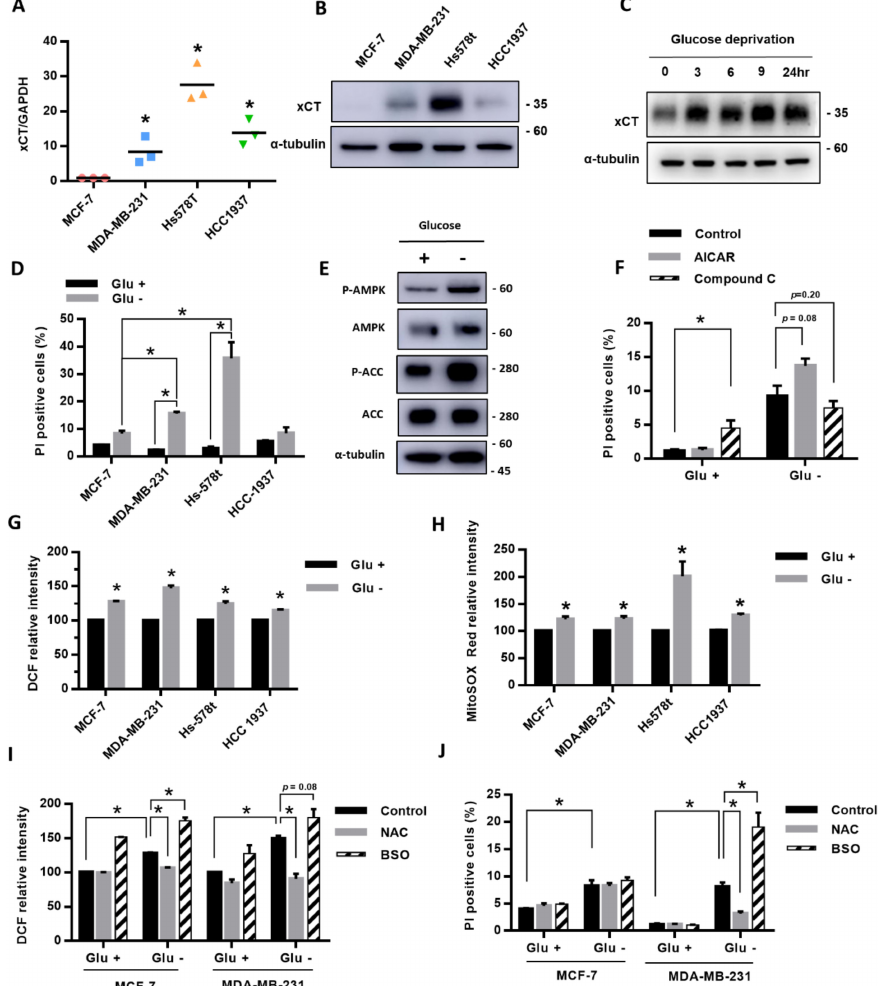
Figure 1. The breast cancer cells with high expression of xCT had higher ROS levels and a higher cell death rate under glucose deprivation. ( A , B ) The expression of xCT in breast cancer cell lines (MCF-7, MDA-MB-231, Hs-578t, and HCC-1937) in the normal culture medium was detected by real-time RT-PCR ( A ) and Western blot ( B ). The relative expression level of xCT of MCF-7 was set as 1. ( C ) The protein levels of xCT after glucose deprivation for 3, 6, 9, and 24 h in MDA-MB-231 cells were detected using a Western blot. ( D )The four breast cancer cell lines were cultured in the medium with or without glucose (25 mM) for 24 h. The cell death rate was evaluated by the flow cytometry with PI exclusion assay. ( E , F ) MDA-MB-231 cells were treated with or without glucose deprivation for 24 h. The protein levels of the AMPK pathway were detected using a Western blot ( E ). The cells were cotreated with the AMPK activator 5-aminoimidazole-4-carboxamide ribonucleotide (AICAR, 1 mM) or the AMPK inhibitor Compound C (Com C, 10 µ M). The cell death rate was detected using flow cytometry with a PI exclusion assay ( F ). ( G , H ) The levels of intracellular ROS and mtROS were detected using flow cytometry with DCFH-dA staining ( G ) and mitoSOX Red dye ( H ). The measured value of ROS from the cells cultured in the glucose-containing medium (control) was normalized as 100%. ( I ) The MCF-7 and MDA-MB-231 cells were cultured in the medium with or without glucose and cotreated with the antioxidant N-acetyl-cysteine (NAC, 1 mM) or the glutathione biosynthesis inhibitor L-buthionine-S, R-sulfoximine (BSO, 150 µ M). The levels of intracellular ROS after NAC or BSO treatment were detected using flow cytometry with DCFH-dA staining. ( J ) The cell death rate was evaluated by the flow cytometry with a PI exclusion assay. The data are presented as the mean ± SEM of the results from three independent experiments in triplicate. n = 3. * ( A , D , F – J ): p < 0.05. Glu + : medium containing 25 mM glucose. Glu -: Glucose-free